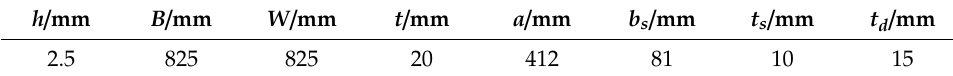
Figure 14. Schematic diagram of single-column steel bridge pier.